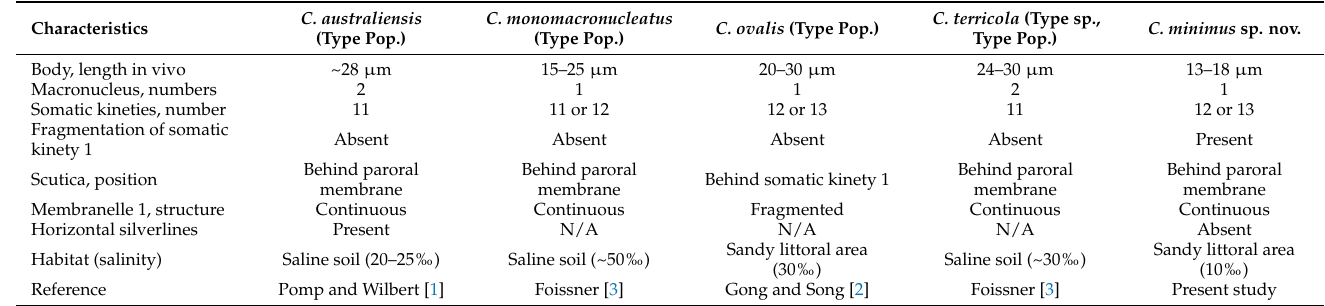
Table 2. Comparison of Cinetochilides minimus sp. nov. with